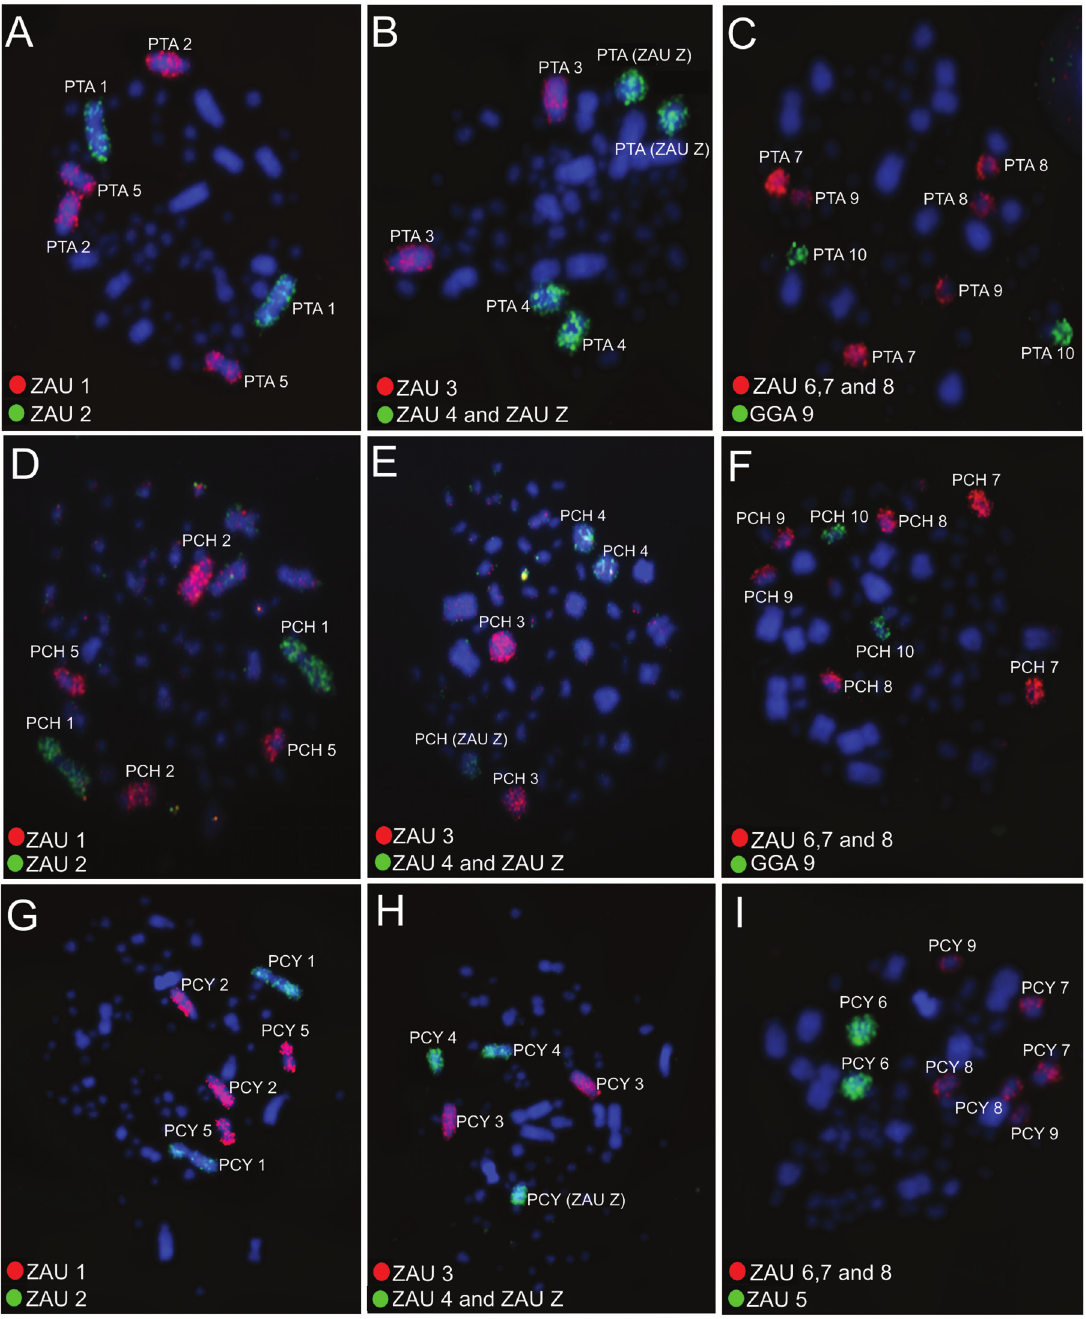
Figure 2 - FISH experiments using Gallus gallus (GGA) and Zenaida auriculata (ZAU) probes hybridized onto P. tapera - PTA (A-C), P. chalybea - PCH (D-F) and P. cyanoleuca - PCY (G-I) metaphases. Probes are indicated in the lower left corner of each image; probes were labeled with biotin/Cy3 (red) or fluorescence